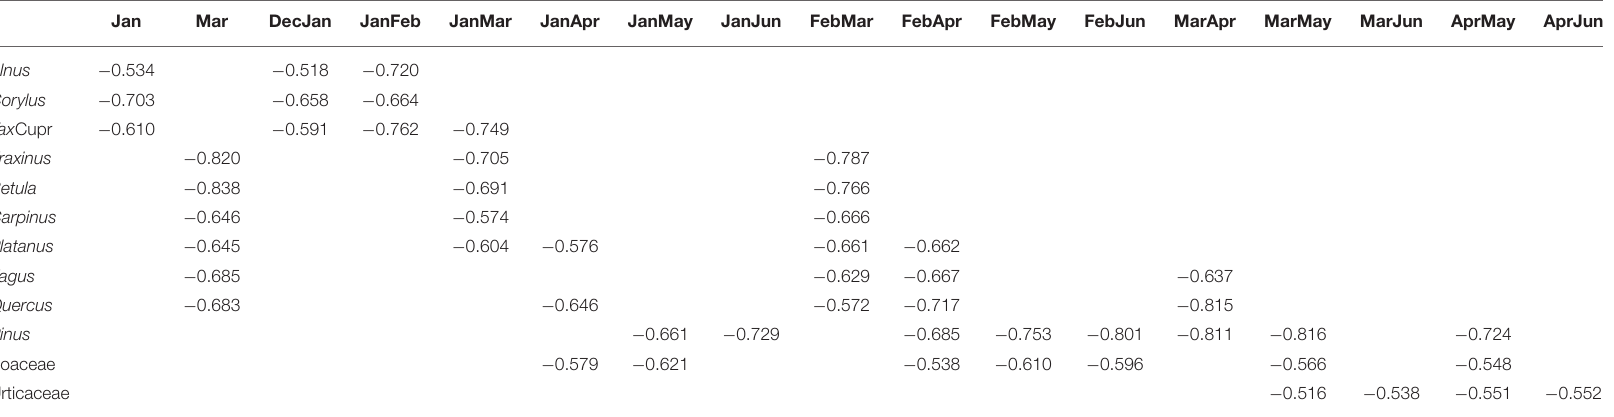
TABLE 5 | Correlation coefficients between temperature and start dates of the pollen season.